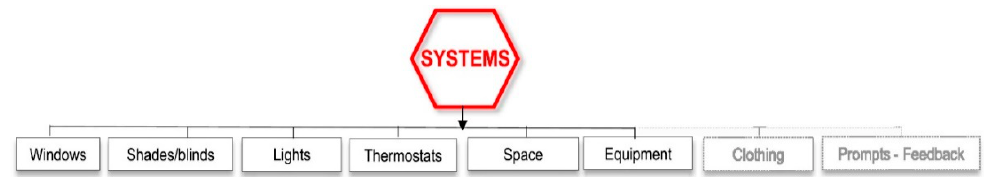
Figure 15. Systems that an occupant can interact with and change the building energy usage [112]